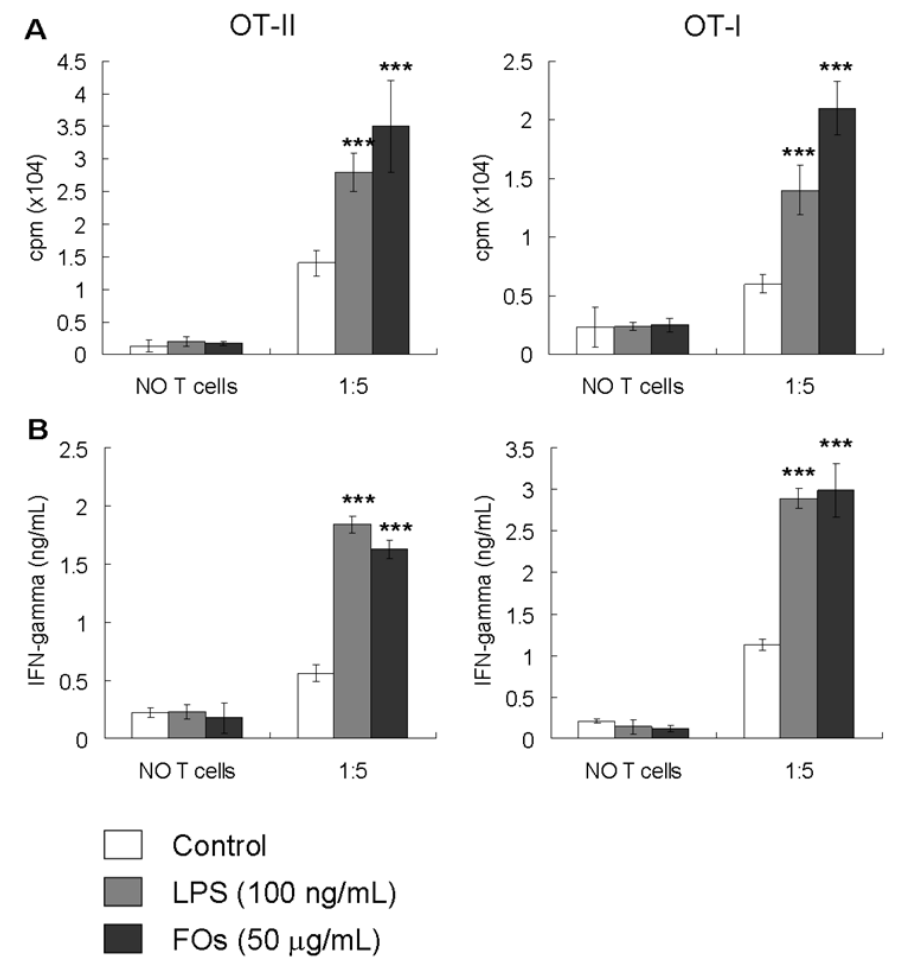
Figure 3. FOs-treated BMDCs increase T cell activation in response to the specific antigen OVA ( A ) CD8 + T cells and CD4 + T cells were prepared from the spleens of OT-I and OT-II mice, respectively. Purified T cells were co-cultured with PBS, LPS (100 ng/mL) or 50 g/mL FOs-treated DCs pulsed with an OVA peptide at the indicated ratio of DCs: T cells for 96 h. Cell proliferation was quantified by [ 3 H]-thymidine incorporation for 18 h. ( B ) Supernatants were collected from cultures after 96 h, and IFN- γ production was measured by ELISA. All data represent the mean ± SD from triplicate well measurements from one of three independent experiments with similar results. *** p < 0.001;